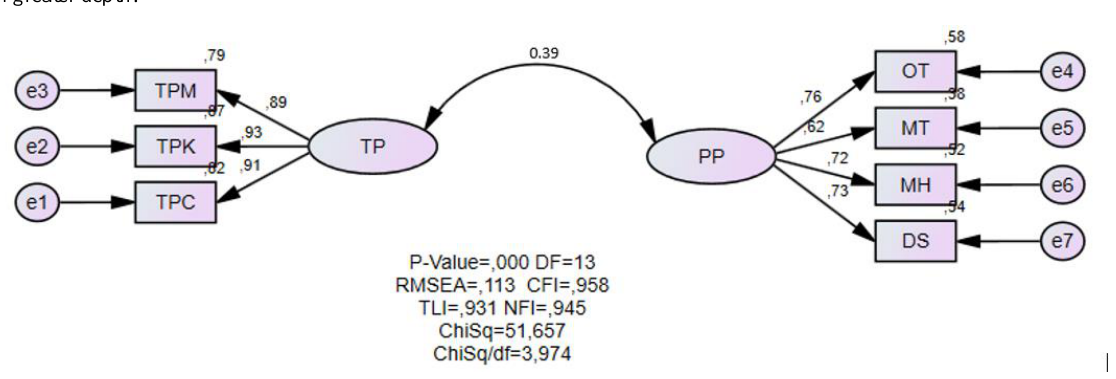
Figure 1: The Structural Equation Model of Perception and Participation in the Public Sphere